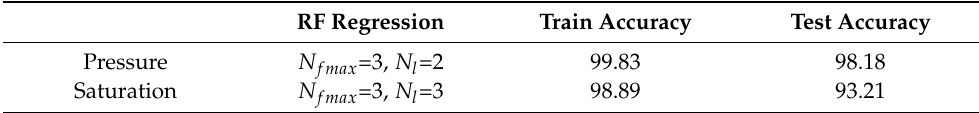
Table 2. Hyperparameters chosen by 5-fold cross-validation for Random Forest Regressor using 100 training samples.